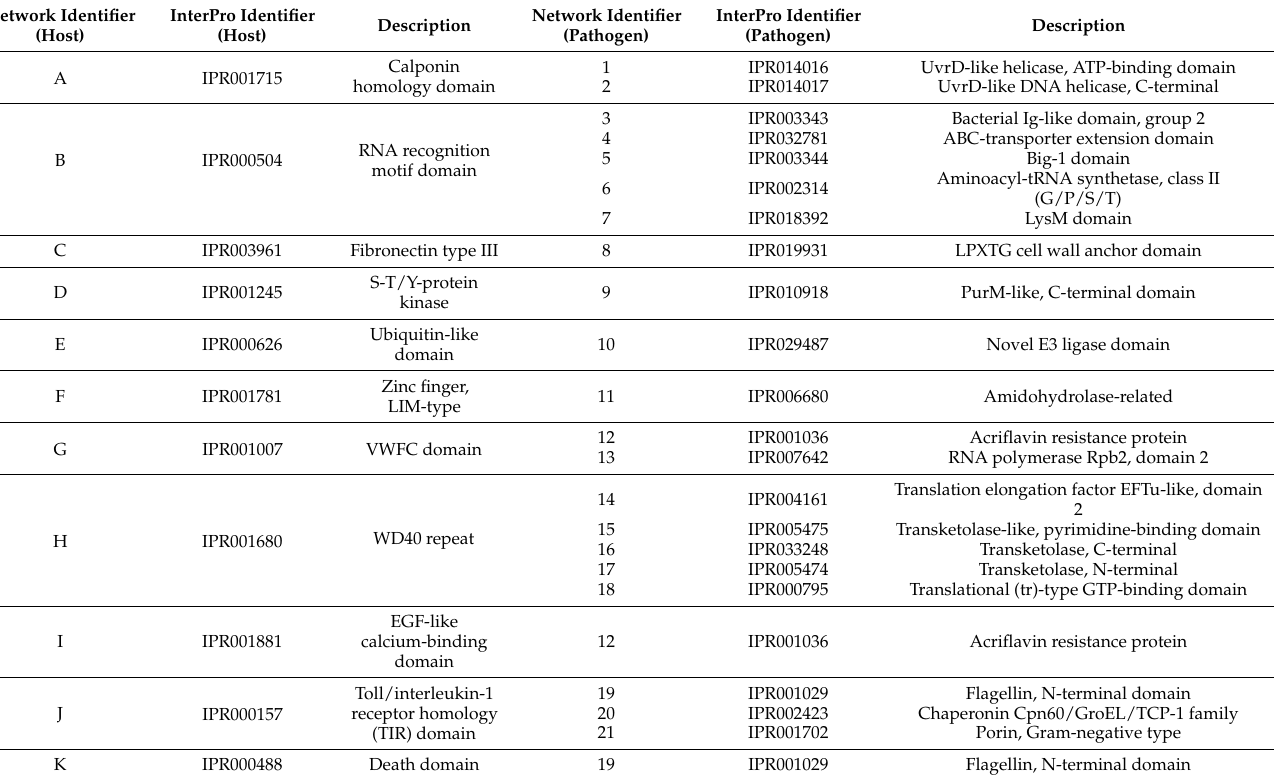
Table 1. InterPro identifiers and short descriptions of the host and pathogenic enriched domains, depicted in Figure